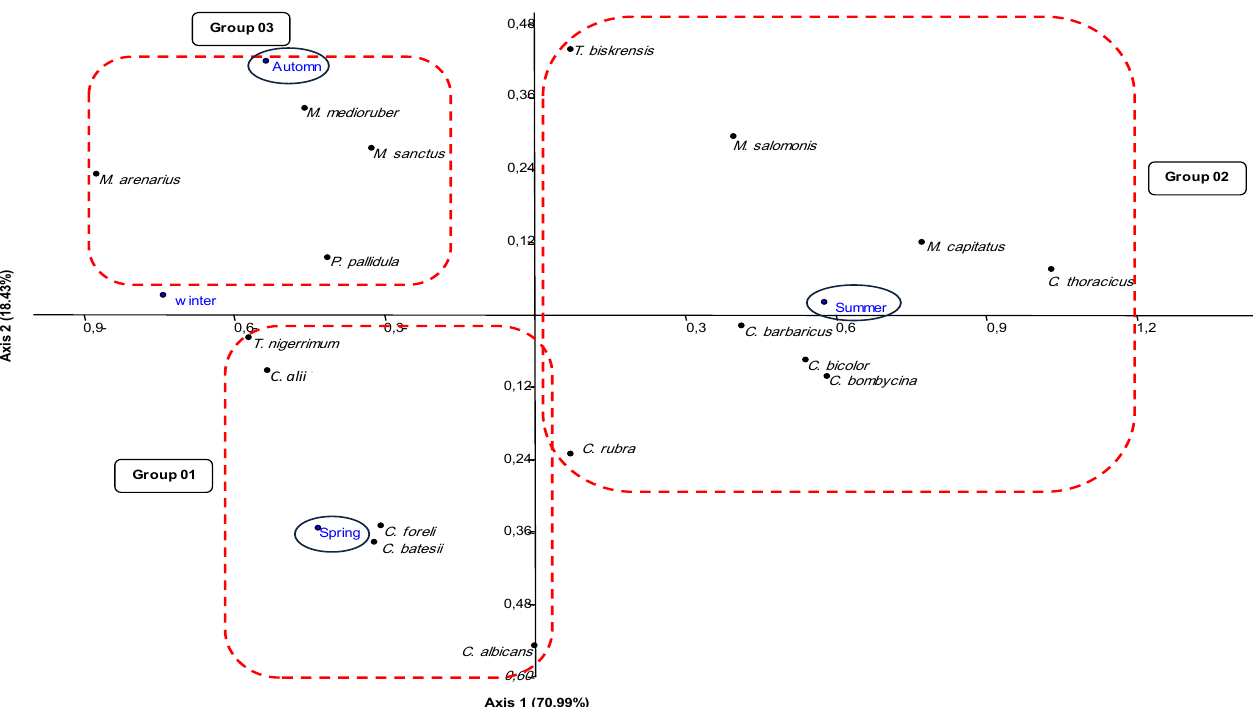
Fig 5. Correspondence Analysis of ant activity according to